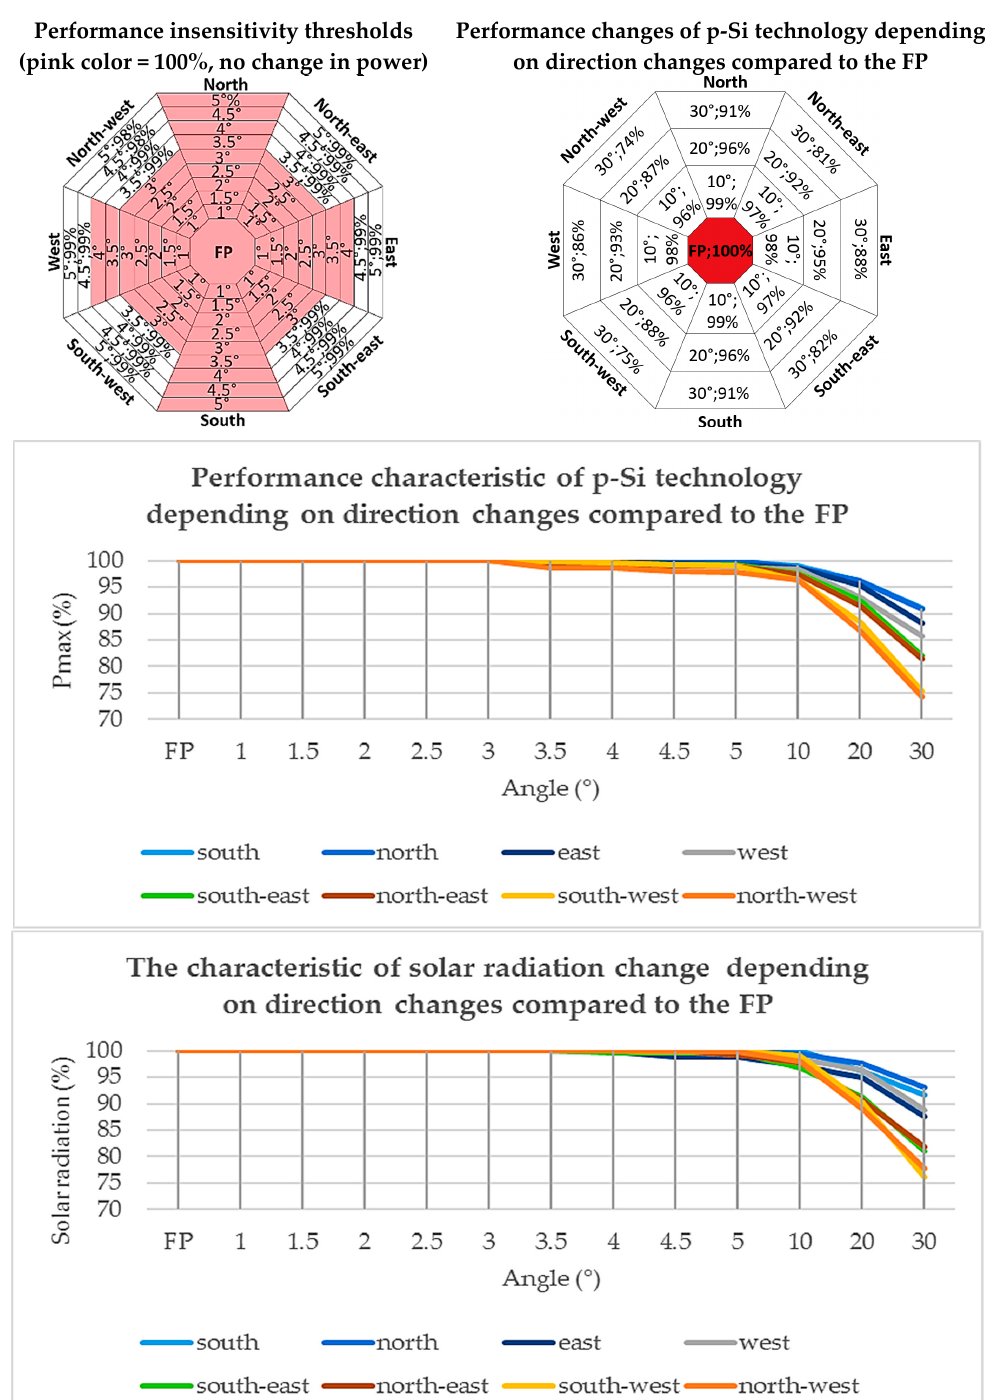
Figure 9. The performance insensitivity thresholds, the performance changes, the solar radiation features and the performance characteristics of p-Si technology depending on directional changes compared to the FP.